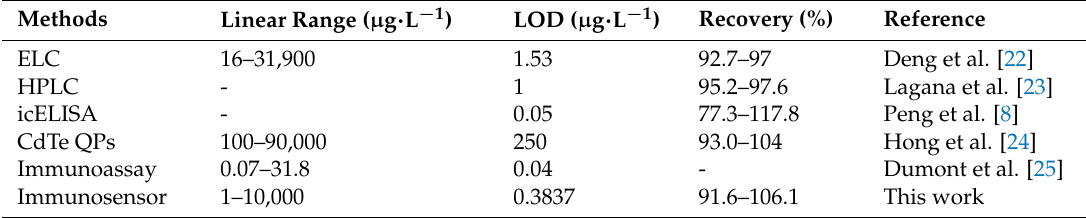
Figure 7. DPV peak current ( A ) and calibration curve ( B ) of the immunosensor at different concentrations of NOR. Table 1. Comparison of this method with other methods reported in the